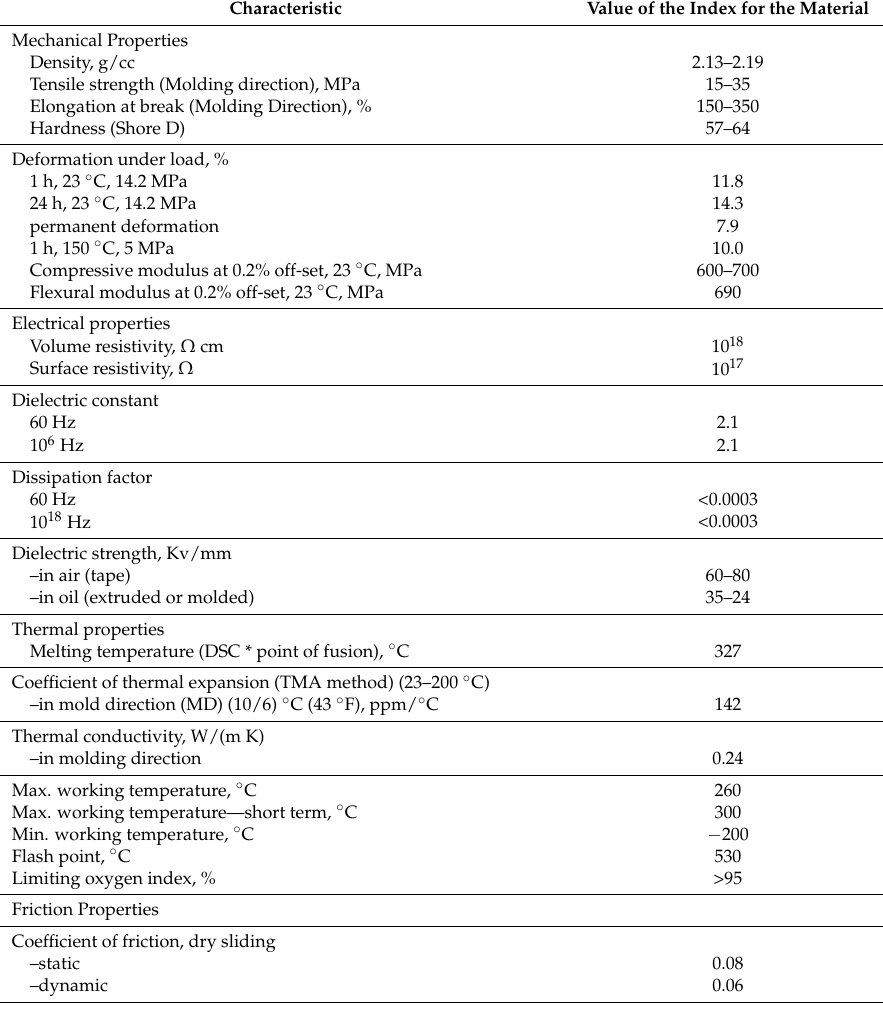
Table 1. Characteristics of polytetrafluoroethylene